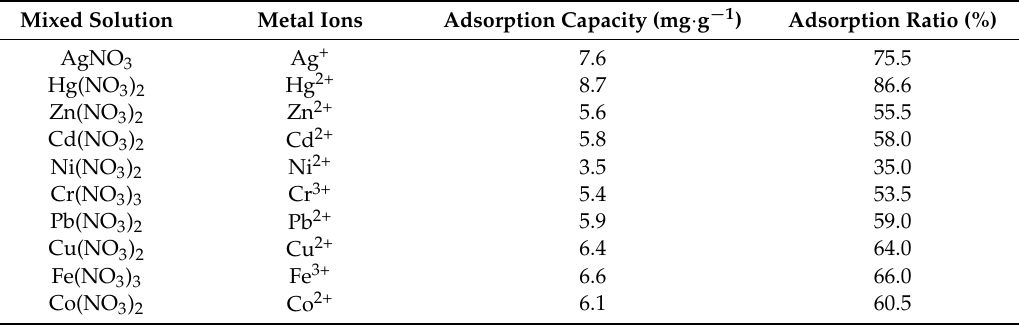
Table 2. Competitive adsorption of ten metal ions onto 100 mg of PTT in 50 mL solution with an initial concentration of 20 mg · L − 1 for each metal ion at 25 ◦ C for 24 h.